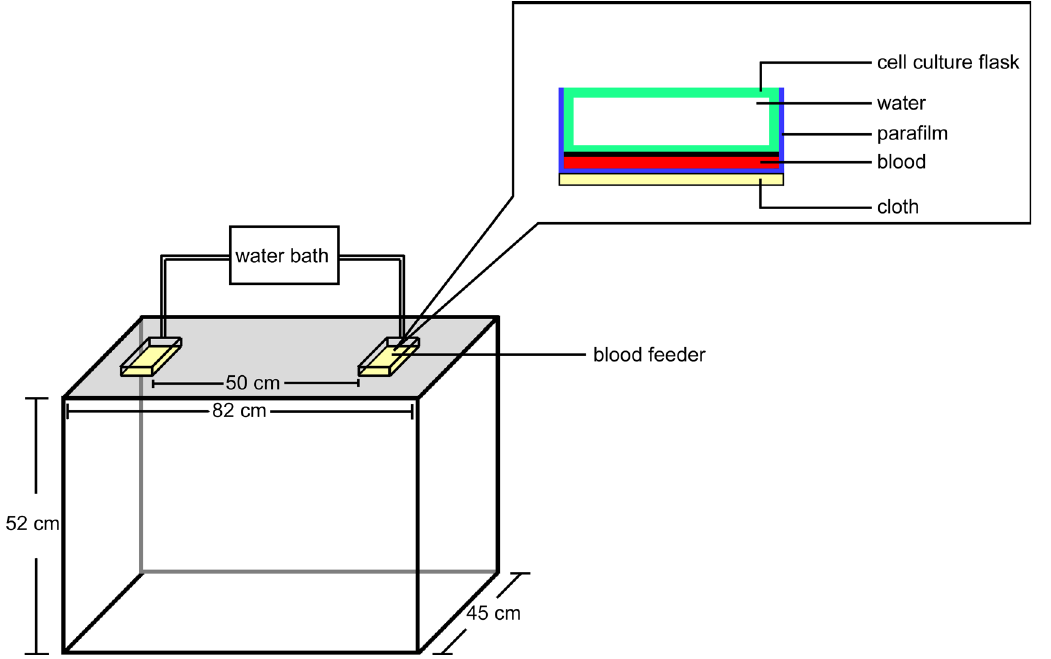
Fig 1. The blood-feeders used to conduct the behavioral assays with 5-8-d-old adult Ae . aegypti in the